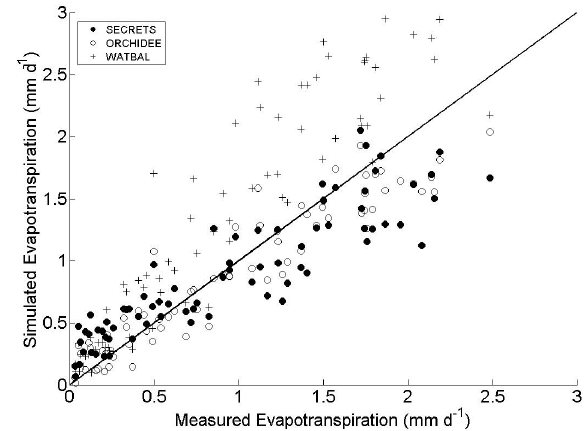
Fig. 4. Mean monthly estimates of latent heat flux measured by eddy covariance (abscissa- mmd − 1 ) and model estimates (ordinate) for SECRETS ( • ), ORCHIDEE ( ◦ ) and WATBAL (+). The solid line represents the 1:1